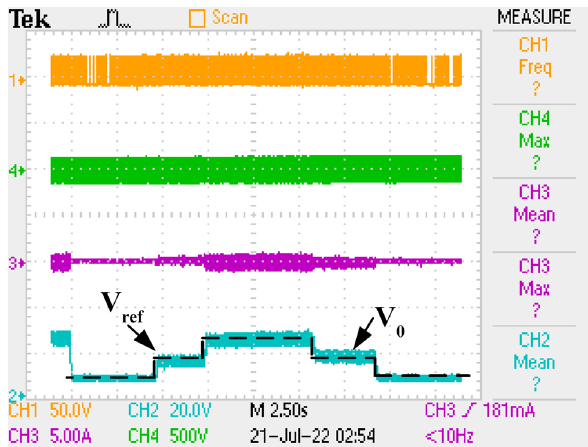
Figure 32. Output Voltage of LCL with C DM filter under reference changes.